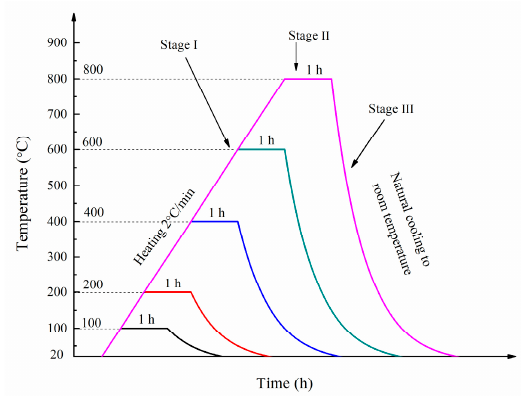
Figure 3. The heating regime.